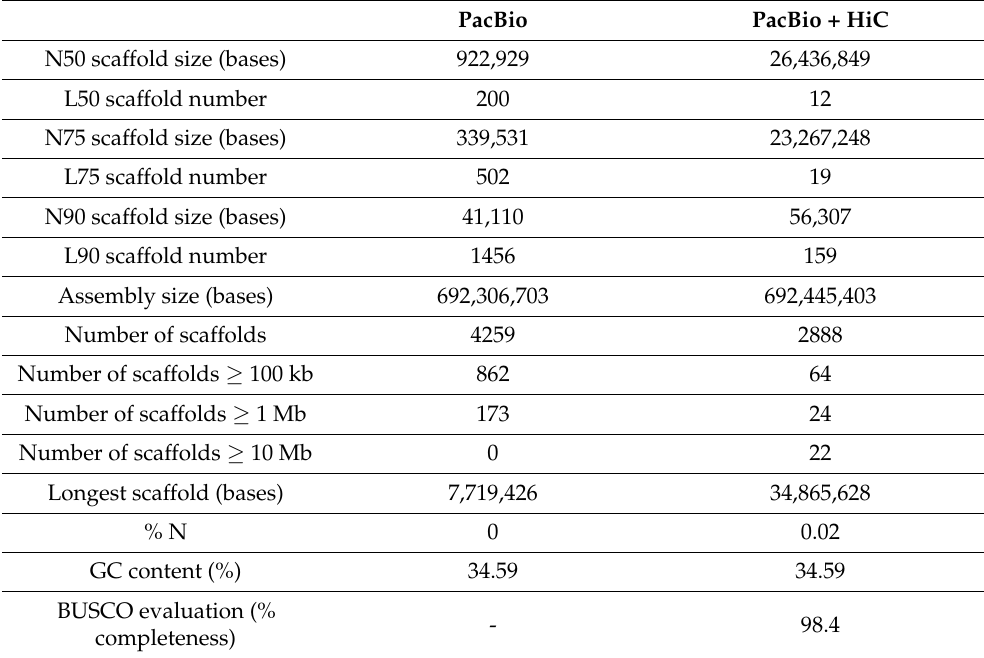
Table 1. Assembly statistics of M. speciosa